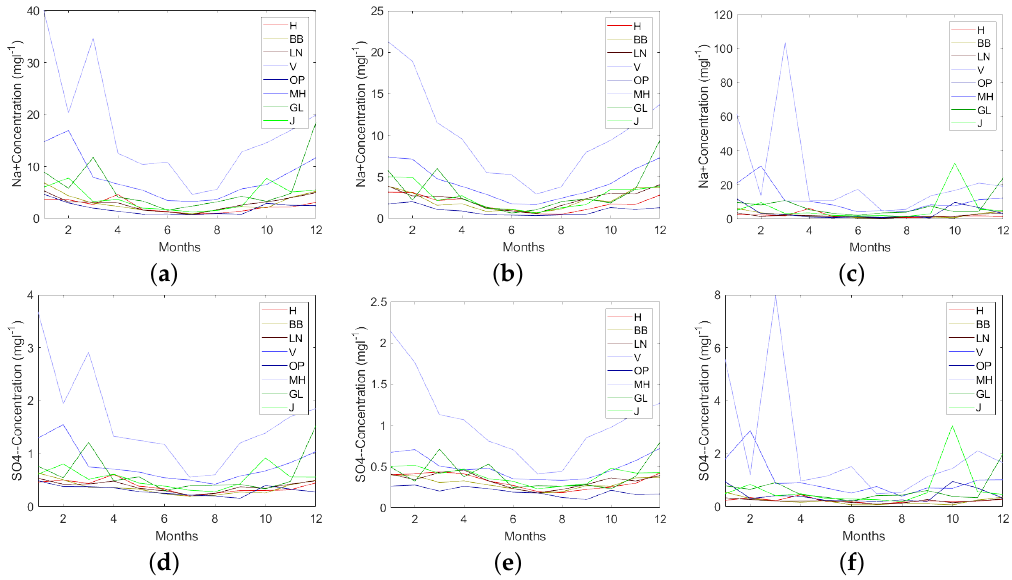
Figure 24. Annual variations in the mean ( a , d ), median ( b , e ) and standard deviation ( c , f ) of sodium and sulphate ion concentrations, respectively, in rainwater collected at each site.